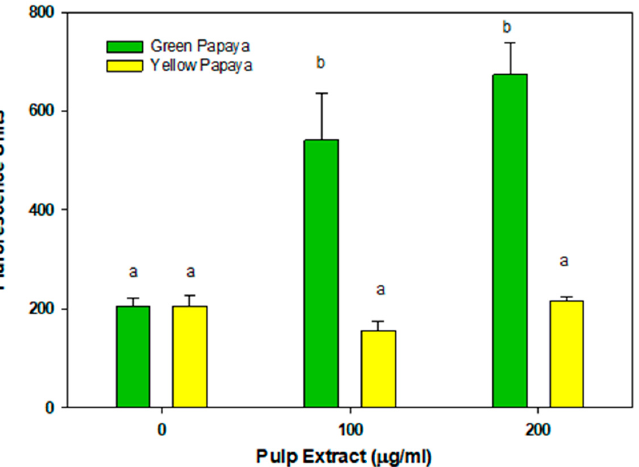
Figure 7. Glucose uptake by green and yellow papaya extract. The glucose uptake stimulatory activity in C2C12 myoblast cells was conducted using a 2-NBD-glucose and a cell-permeable glucose analog (Cayman Chemical Glucose Uptake Cell-Based Assay Kit) following steps as described in the text. The experiment was conducted in triplicate and data were expressed as arbitrary fluorescence units. Statistical analysis of data was performed using one-way ANOVA (analysis of variance) with Tukey’s HSD post hoc test. The statistically significant difference was within p < 0.05 and was represented by different letters.